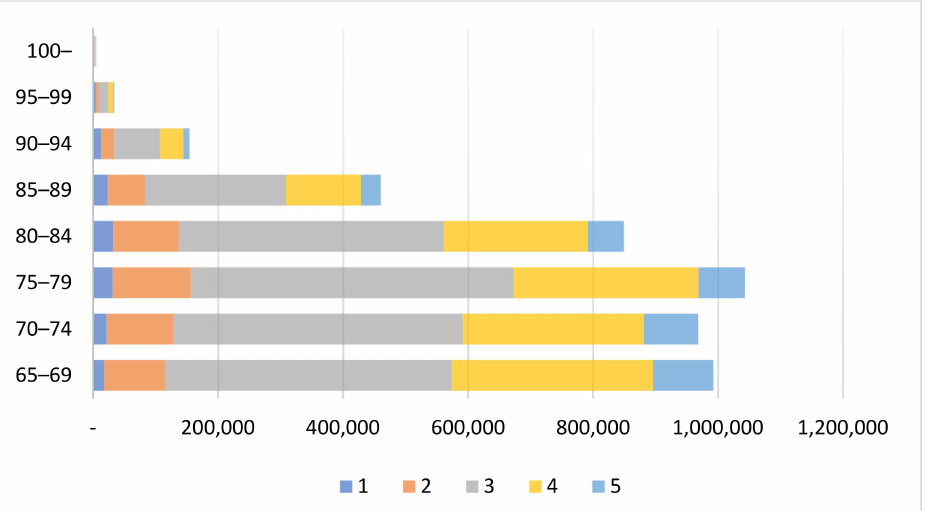
Figure A2. The number of elderly patients in each five-year age bracket with each Korean Triage and Acuity Scale (KTAS) score